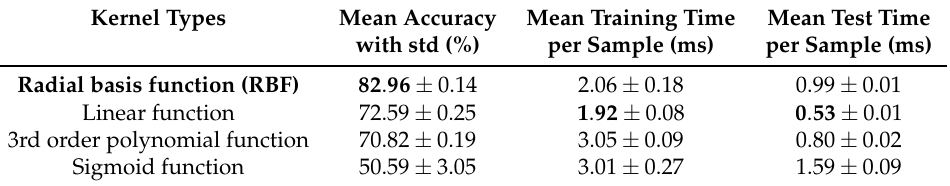
Table 2. Comparison of the SVM configurations based on the kernel functions.